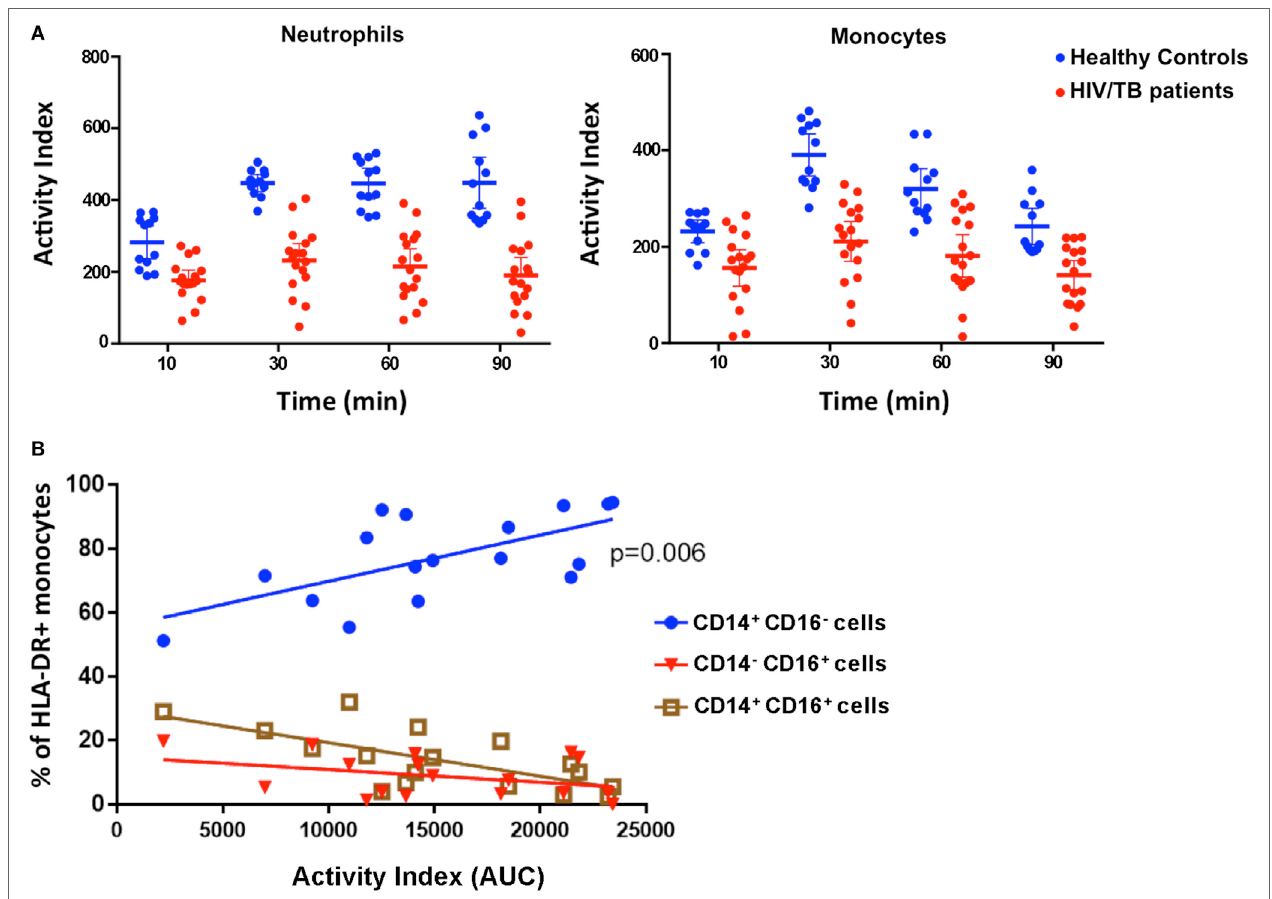
FIGURe 5 | Phagocytosis, superoxide burst, and monocyte phenotypes in peripheral blood phagocytes of HIV/tuberculosis (TB)-coinfected patients. (A) The superoxide burst activity index (AI) over time comparing cells from healthy individuals (blue) with cells from HIV/TB-coinfected patients (red). Lines represent means, and error bars are 95% CI. Mean AIs were lower in the HIV/TB patients at all time points analyzed (paired t -tests, all p < 0.0001). (B) The association between the proportion of HLA-DR + monocytes that are CD14 ++ CD16 − (classical), CD14 + CD16 + (intermediate), and CD14 − CD16 + (non-classical), and monocyte phagocytosis and superoxide burst AI (measured as “area under the curve”). There is a strong association between higher proportions of classical monocytes and increased AI ( p = 0.006) ( n = 18). The data in panel (A) are from four health volunteers in triplicate, and the data in panel (B) are from 18 HIV/TB